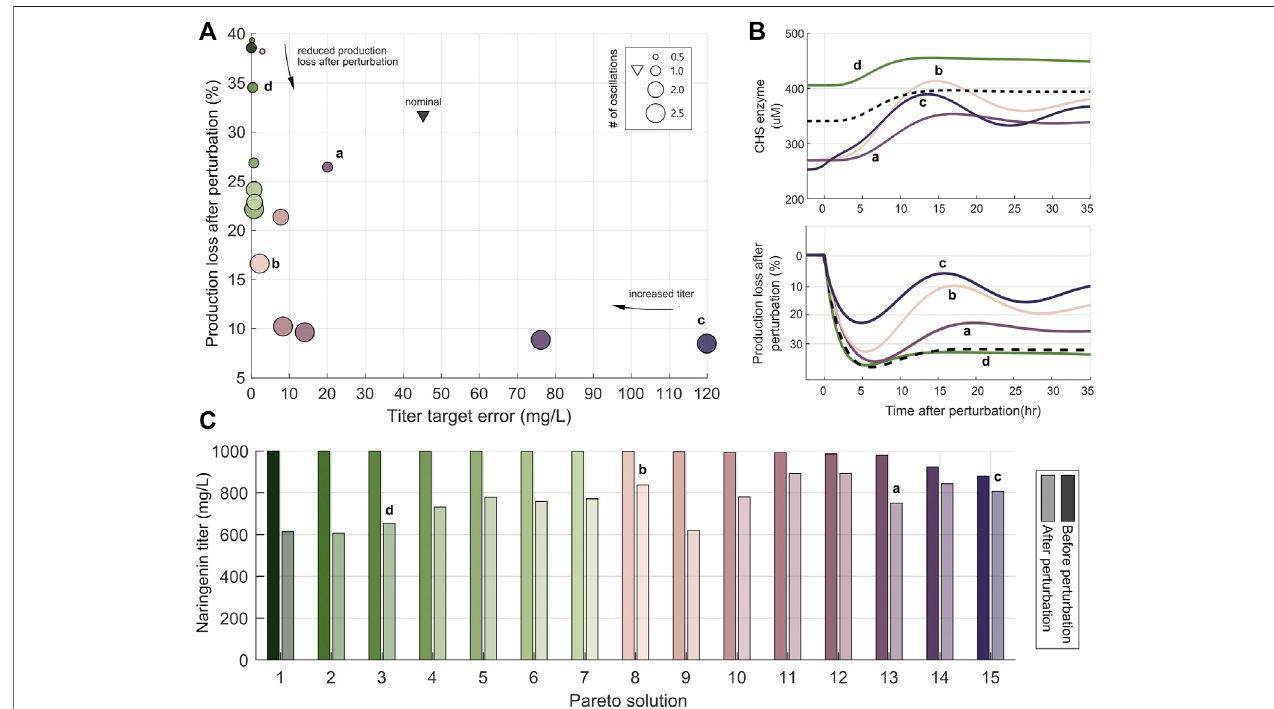
FIGURE 5 | Optimal controller and biosensor tuning in the naringenin dynamic pathway regulation. (A) Pareto front of the optimal solutions. The x -axis is the objective J 1 (titertargeterror),the y -axisistheobjective J 2 (productionlossafterperturbation),andthesizeofthecirclesrepresenttheobjective J 3 (numberofoscillations) that take into account the transient response of the controller to a perturbation. Solutions along the Pareto front are identi fi ed with color ranging from dark green to dark violet asthe valuesof objective J 1 increase. Green solutionshave smaller target error than pink/purple/violet ones. The black triangle represents thepreliminary not optimized con fi guration. Solutions a - d arerepresentative ofthedifferentzones alongthePareto front. (B) Timeresponseofthe selectedsolutions.Top plot:responseof the CHS enzyme after a perturbation in the secondary metabolite Malonyl-CoA. Bottom plot: time response of the production loss after perturbation with respect to the level achieved before the perturbation for the four selected solutions. In both plots the black dashed line corresponds to the preliminary not optimized solution. (C) Naringenin titer before and after perturbation of each one of the Pareto solutions. The color codes are common to all the plots in the fi